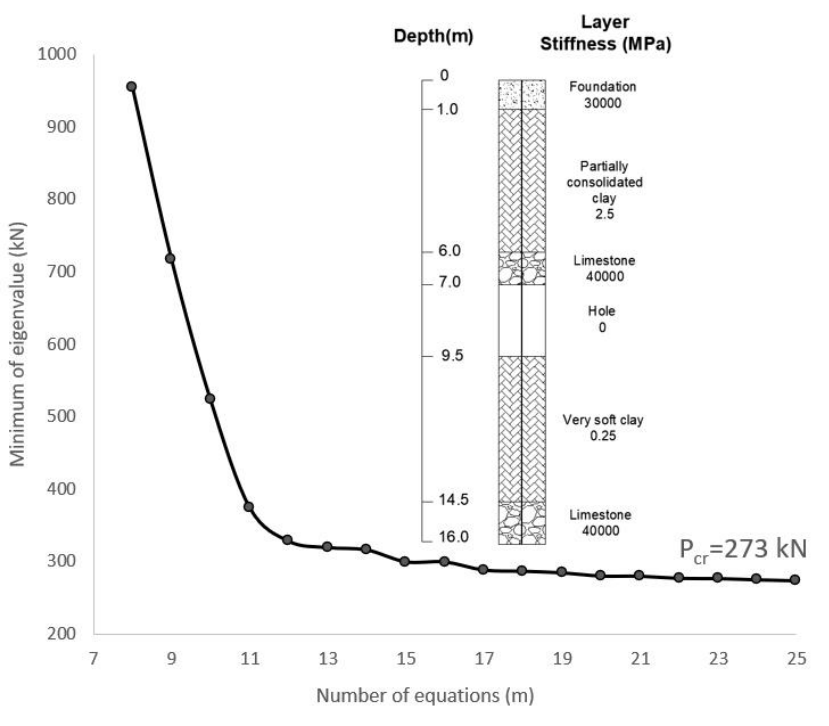
Figure 3. An example of convergence to P cr of the minimum of the eigenvalues as the number of equations increases in a pile with EI = 100 kNm 2 .